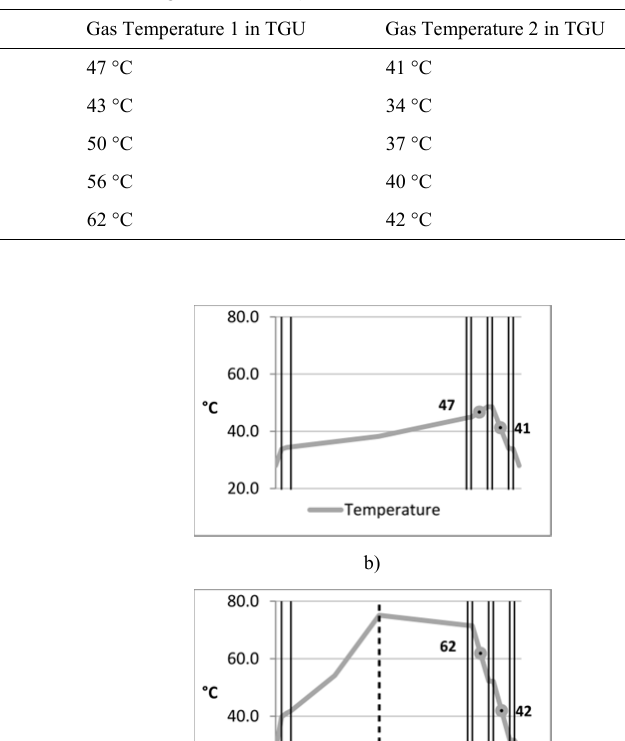
Table 1: Average Gas Temperature of IGU in combination with non-transparent sunblind’s in ventilated DSF’s (Visual sunblind characteristics according to EN 13363-2)